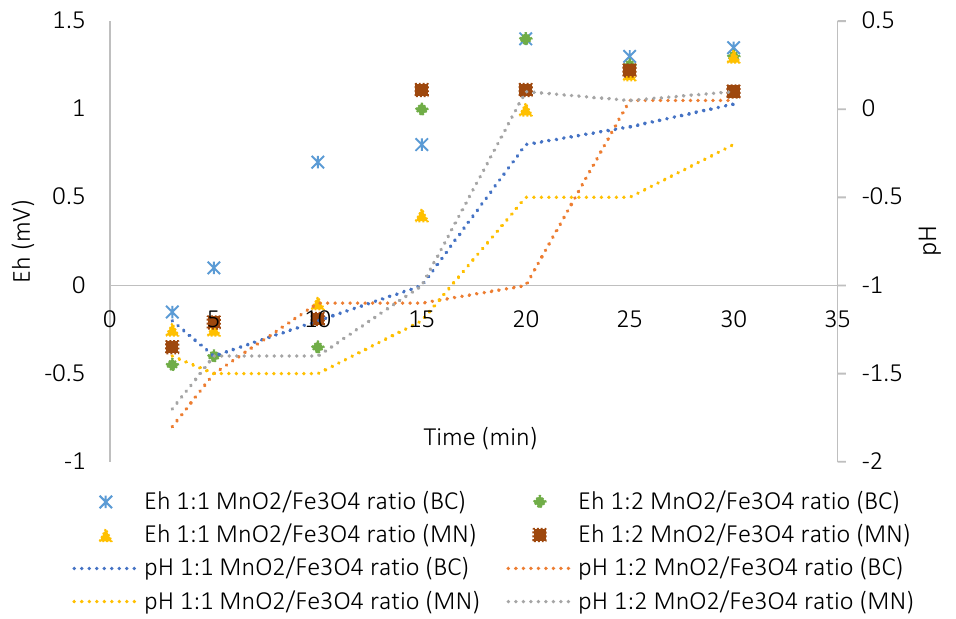
Figure 5. Effect of potential and pH in solution at different ratios of MnO 2 /Fe 3 O 4 .